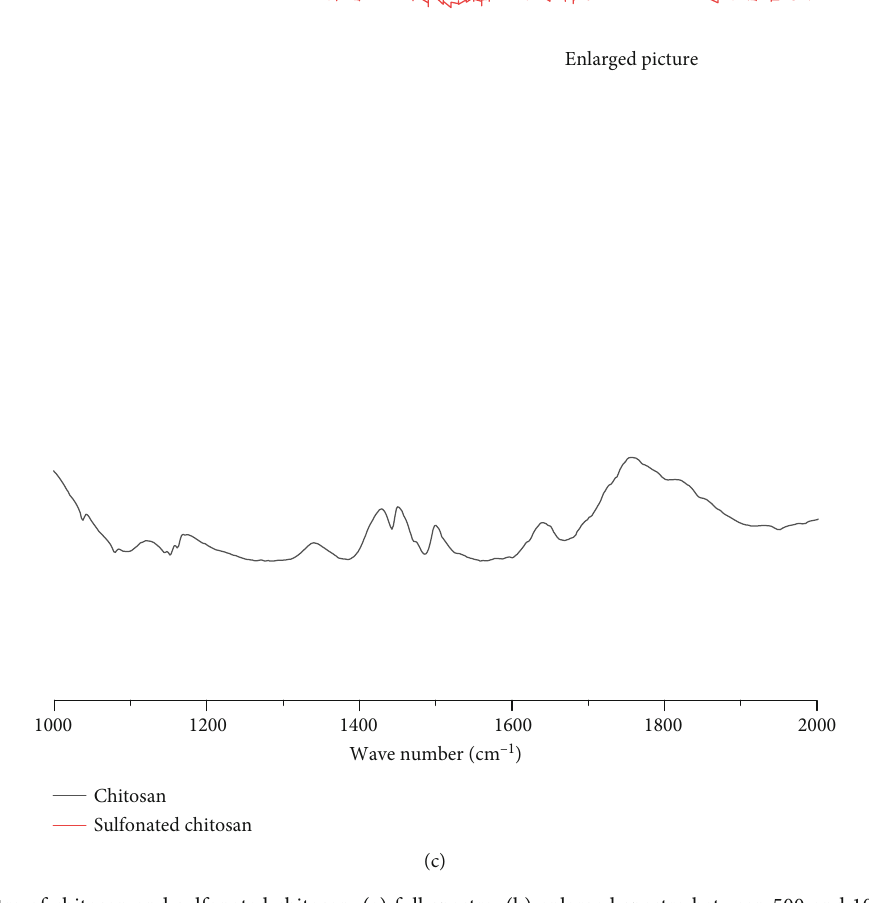
Figure 1: FTIR spectra of chitosan and sulfonated chitosan: (a) full spectra; (b) enlarged spectra between 500 and 1000cm -1 ; (c) enlarged spectra between 1000 and 2000cm -1